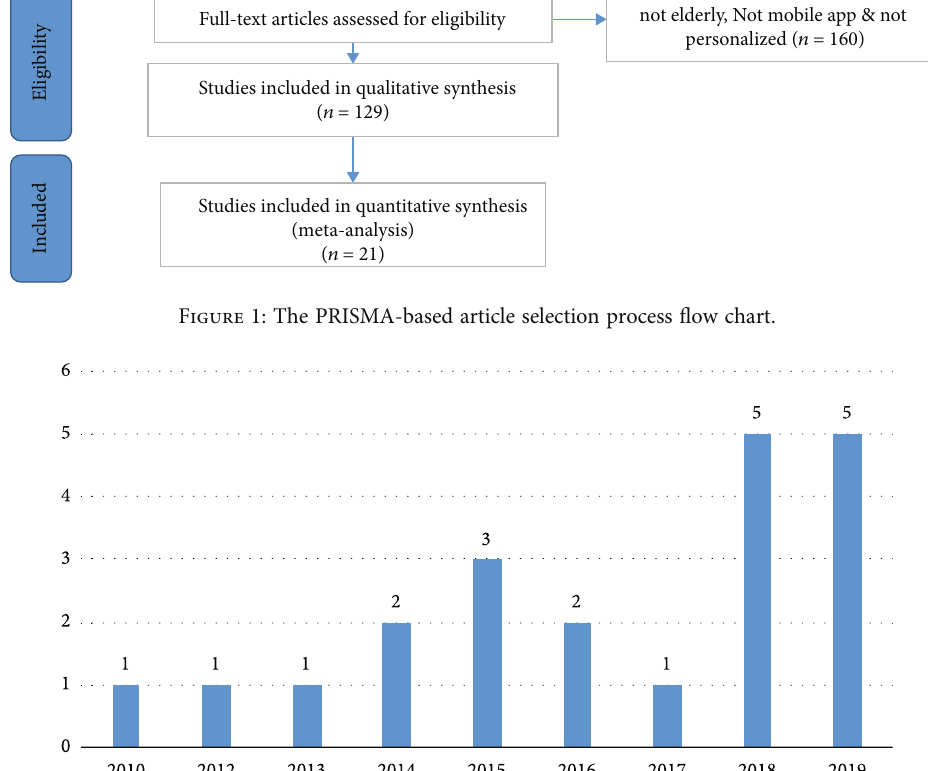
Figure 2: Articles published based on year, from 2010 to